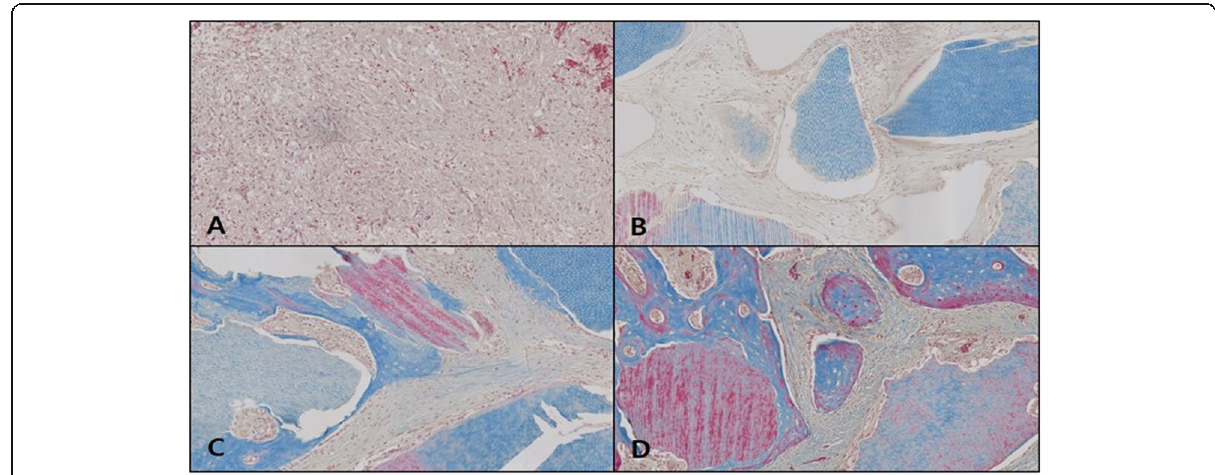
Fig. 12 Microphotograph at 1 week ( A ), 2 weeks ( B ), 4 weeks ( C ), and 6 weeks ( D ) after bone graft with organic matter removed particulate autogenous tooth and type 1 collagen in experimental rabbit. Masson.